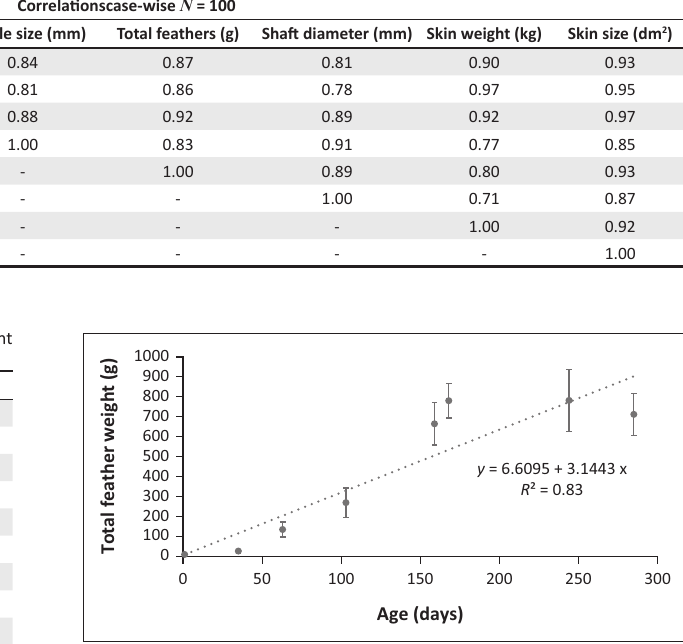
FIGURE 1: The total feather weight (standard deviation bars) of ostriches with an increase in